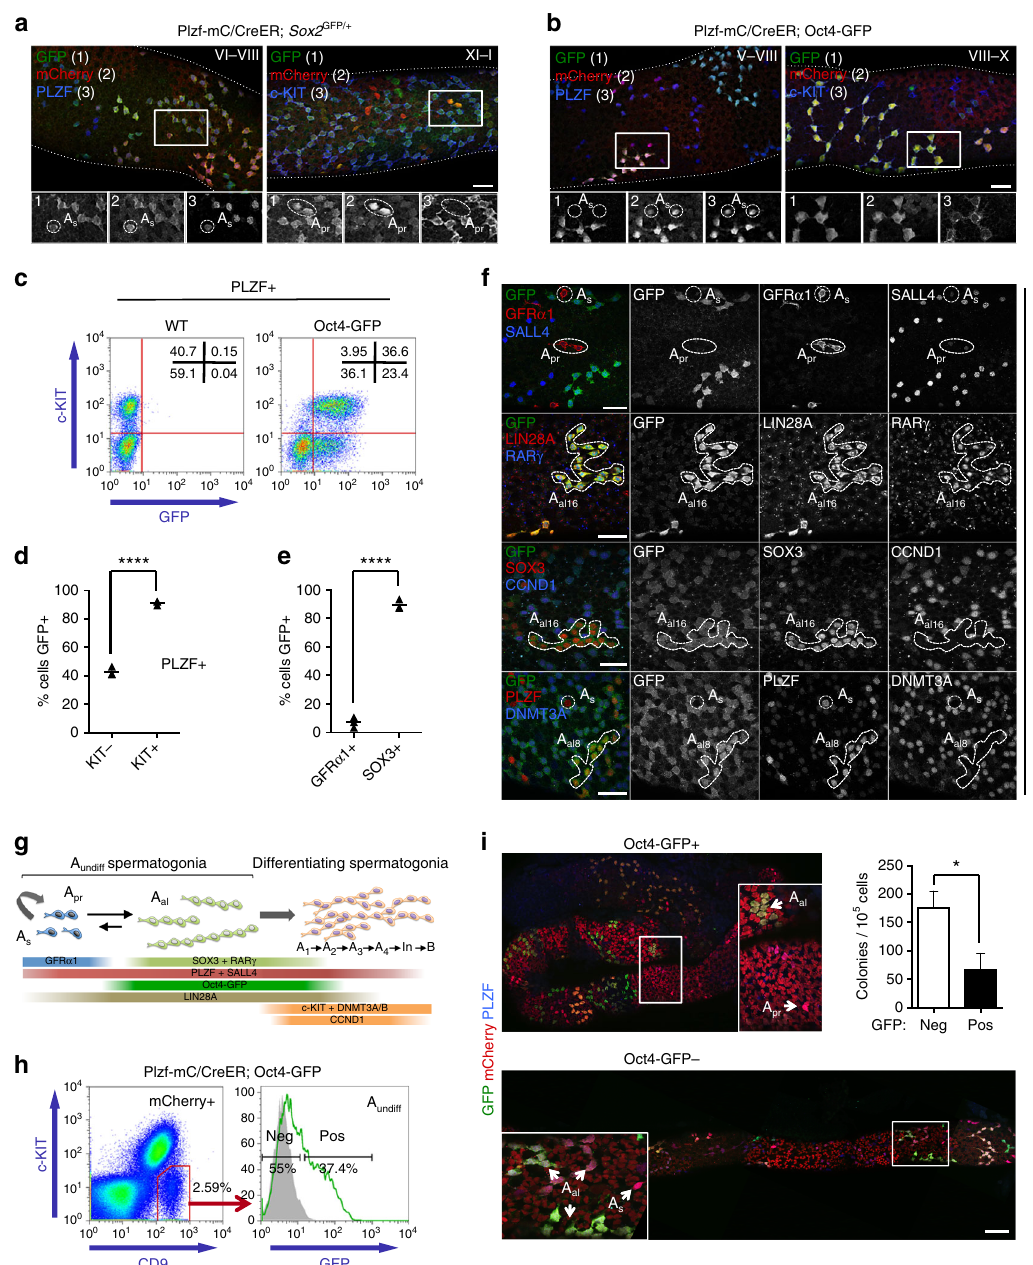
Fig. 2 Comparative analysis of reporter gene expression in spermatogonia. a , b Representative whole-mount IF of adult (8 – 10 weeks post natal) Plzf-mC/ CreER; Sox2 GFP ( a ) and Plzf-mC/CreER; Oct4-GFP ( b ) seminiferous tubules. Inset panels show individual immunostaining within indicated area at higher magni fi cation. Tubule staging and select A s and A pr are indicated. Scale bars, 50 μ m. c Representative fl ow cytometry analysis of fi xed and permeabilized testis cells from 1 of 3 Oct4-GFP and wild-type (WT) control adults. PLZF + cell population is shown. Percentages of cells contained within gates are indicated. d Quanti fi cation of fl ow cytometry results from c . Graph indicates percentage of A undiff (PLZF + c-KIT − ) and cells initiating differentiation (PLZF + c-KIT + ) expressing GFP in Oct4-GFP adults. Horizontal bars indicate mean values ( n = 3 mice). e Graph shows percentage of GFR α 1 + and SOX3 + spermatogonia positive for GFP in whole-mount seminiferous tubules of Oct4-GFP adults. Spermatogonial identity was con fi rmed by SALL4 counterstain. Horizontal bars indicate mean values ( n = 3 mice, >200 cells scored per data point). f Representative whole-mount IF of adult Oct4-GFP seminiferous tubules for indicated markers ( n = 3 mice). Select A undiff cells are indicated. Scale bar, 50 μ m. g Scheme summarizing expression patterns of indicated genes and transgenic reporters plus changes in cell morphology during spermatogonial differentiation. Markers used to isolate different spermatogonial populations are indicated. h Isolation of Oct4-GFP − and Oct4-GFP + A undiff from Plzf-mC/CreER; Oct4-GFP adults by fl ow cytometry. Percentage of cells in each gate from a representative sample is indicated ( n = 6 mice). i Oct4-GFP − and GFP + adult A undiff fractions were transplanted into recipients and analysed 8 weeks later by whole-mount IF. Images show GFP and mCherry expression in representative colonies. PLZF counterstain con fi rms A undiff and spermatogonial identity. Panels show higher magni fi cation details of indicated areas. Scale bar, 100 μ m. Graph shows colony-forming ef fi ciency of Oct4-GFP + and GFP − A undiff fractions. Data is presented as mean number of colonies per 10 5 donor cells±s.e.m. ( n = 7 recipient testes for Oct4-GFP − cells and n = 6 for Oct4-GFP + cells). Donor cells were pooled from 2 Plzf-mC/CreER; Oct4-GFP adults. Signi fi cance was calculated by two-tailed Student ’ s t -test (* P <0.05, **** P <